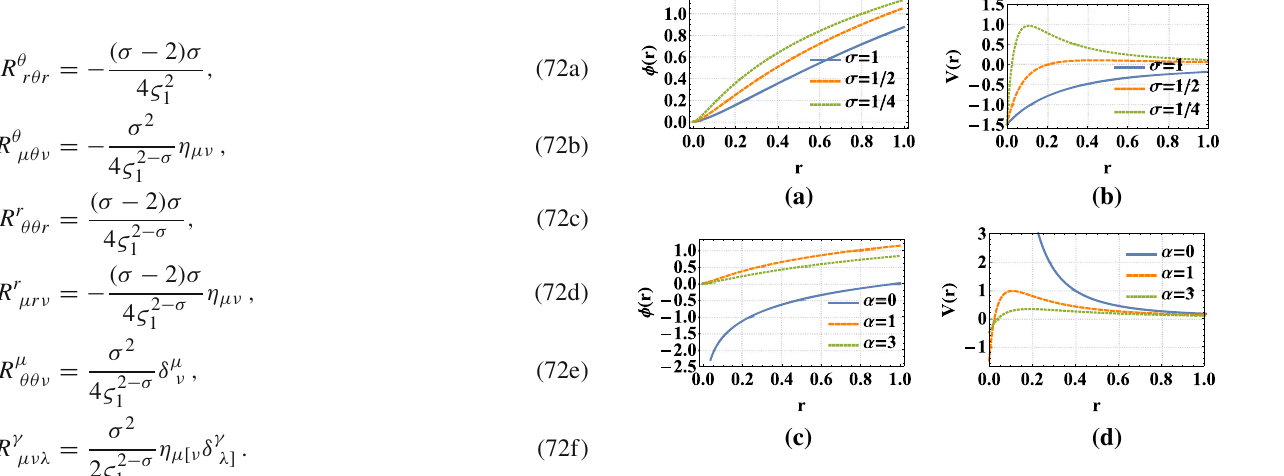
Fig. 7 The scalar field (68) and the scalar potential (66) at the D → 4 limit. a Thescalarfield φ( r ) and b thescalarpotential V ( r ) fordifferent values of the parameter σ with α = 1. c The scalar field φ( r ) and d the scalar potential V ( r ) for different values of the GB coupling constant with σ = 1 /